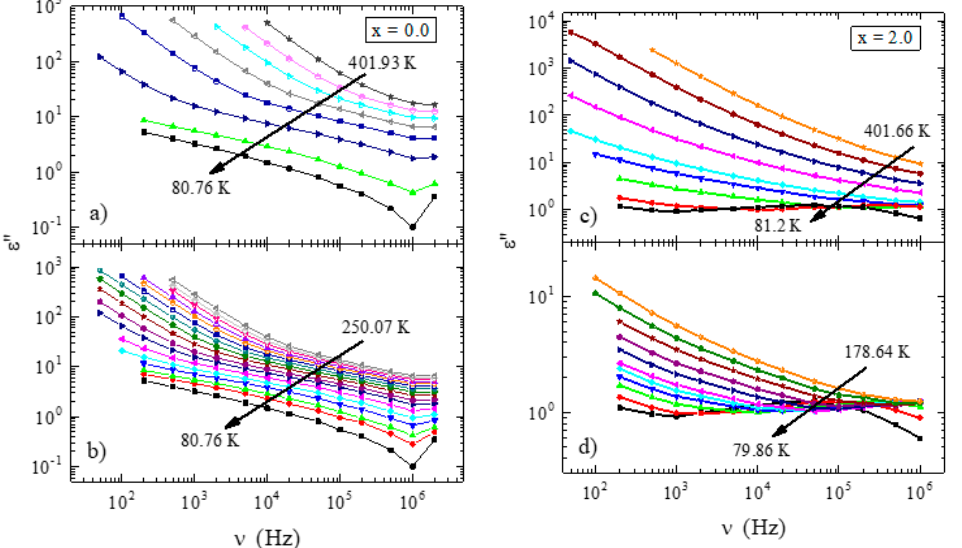
Figure 9. Frequency dependence of the dielectric loss spectra presented for various temperatures, ε ”(v), for x = 0.0 with ∆ T ≈ 50 K (20 K between two lowest temperatures) ( a ) and with ∆ T ≈ 10 K ( b ), and for x = 2.0 with ∆ T ≈ 50 K (10 K between two lowest temperatures) ( c ) and with ∆ T ≈ 10 K ( d ). Arrows indicate the direction of the temperature evolution of the relaxation process with cooling.